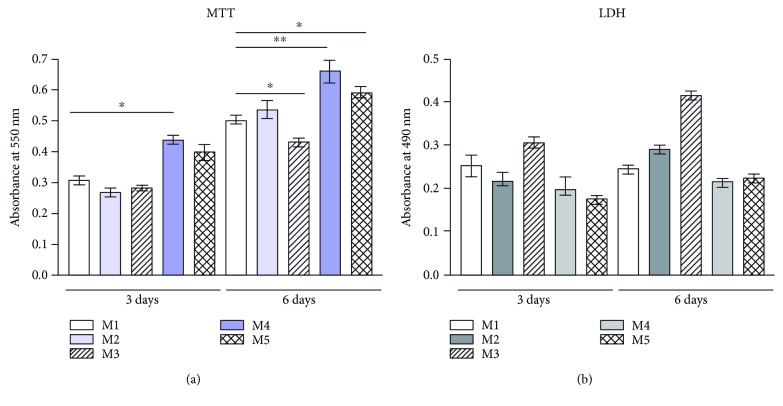
(a) Cell viability obtained after 3 and 6 days of hASCs contact with M1—M5 matrices, as shown by MTT quantitative assay. (b) Cytotoxic potential of M1-M5 matrices, as revealed by LDH assay after 3 and 6 days of culture in standard conditions.